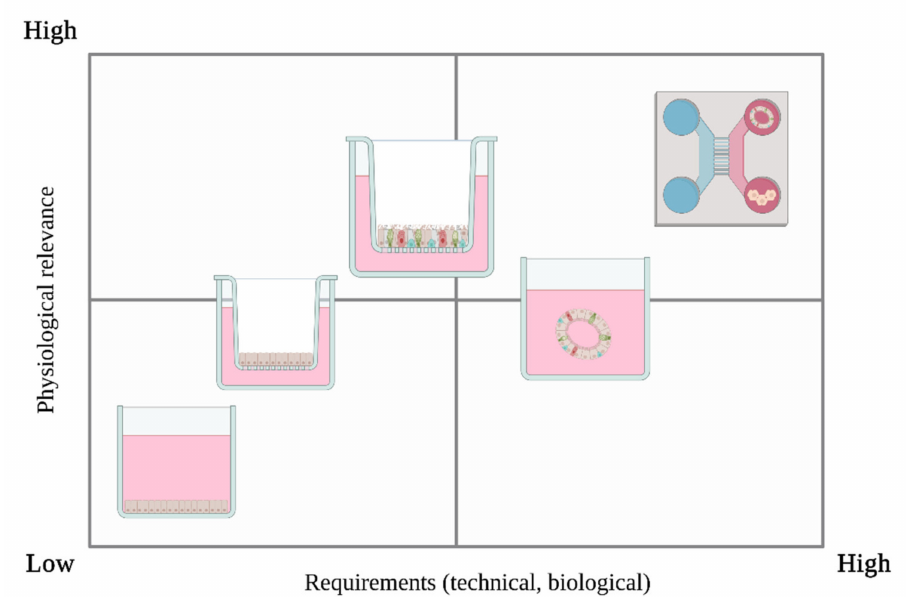
Figure 3. Biological model systems comparisons between physiological relevance and require- ments. Submerged system, Single-cell Air-liquid interface (ALI), Multi-cell Air-liquid interface (ALI), Organoids and Multi-organ chip approach (from left to right). Created with BioRender.com, accessed on 20 August